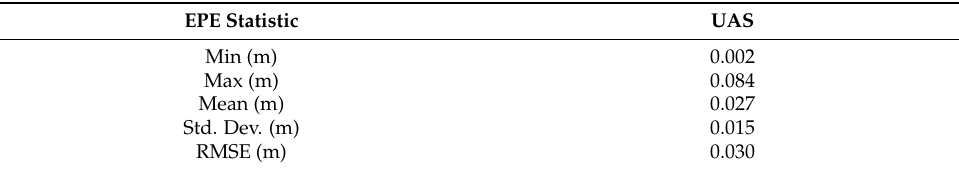
Table 7. Horizontal accuracy of the proposed method evaluated using 0.1 m DEMs derived from UAS SfM MVS data collected in tandem with the TLS data across the same extents. Reported as EPE (end-point error) in meters compared to the ground truth.